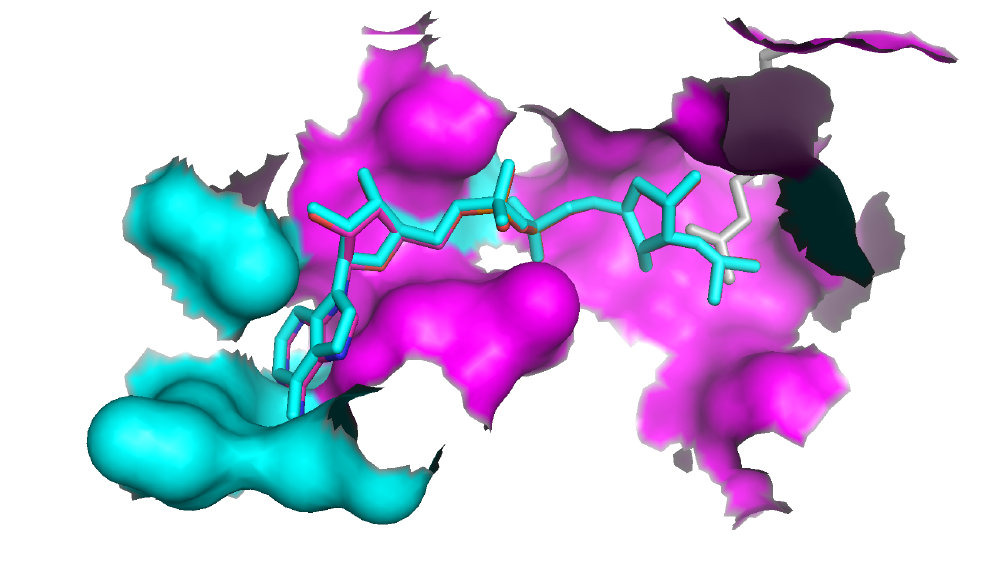
Figure 7. The part of the human Sir2 protein structure (PDB-code 1MA3) matched with the OAR binding pocket of yeast Hst2. All 17 residues shown as molecular surface have been found as “unspecific” match. A subset of these (magenta) has been matched with the amino- acid specific mode. The molecule in sticks-representation in the center is OAR transformed into the empty binding pocket of Sir2 from the structure of the original complex with Hst2 using the co-ordinate transformation derived from the match (there are two very close OAR positions, derived from the specific and unspecific match, respectively). The grey sticks in the right half are an acetylated Lys residue of a substrate-peptide complexed with